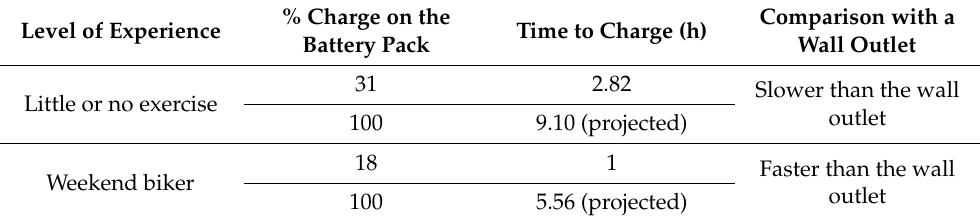
Table 5. Charging speed in comparison to a wall